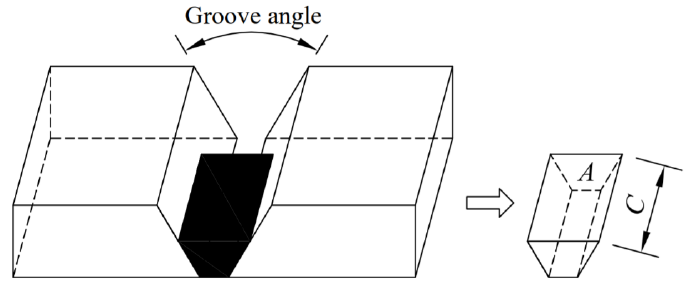
Figure 7. Action volume of the heat source.